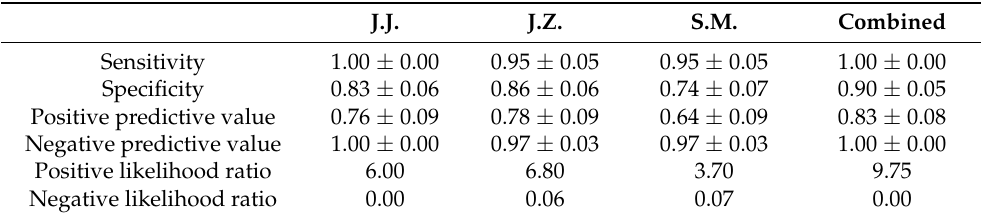
Table 2. Statistical analysis of the individual readers and median combination of the individuals.